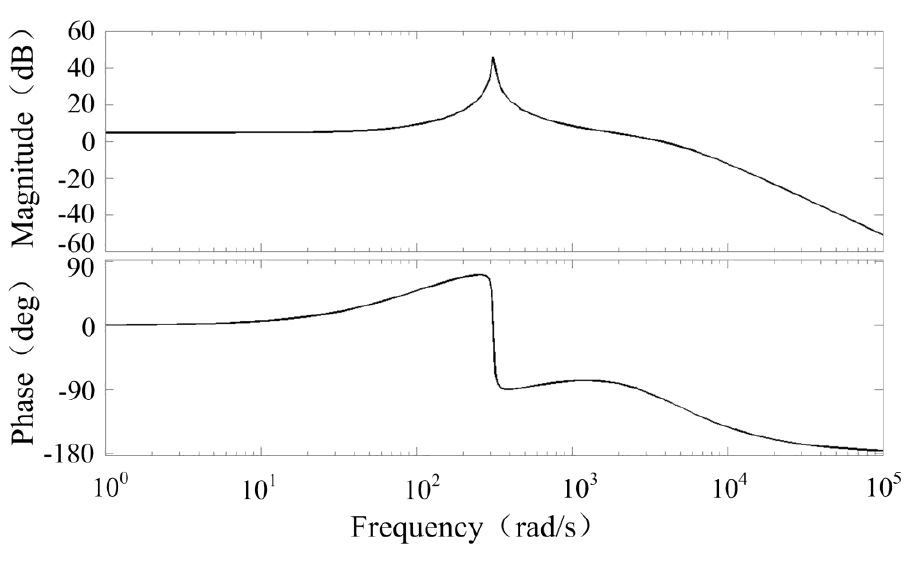
Figure 5. Bode diagram of the loop gain function of the inverter-link under double-loop